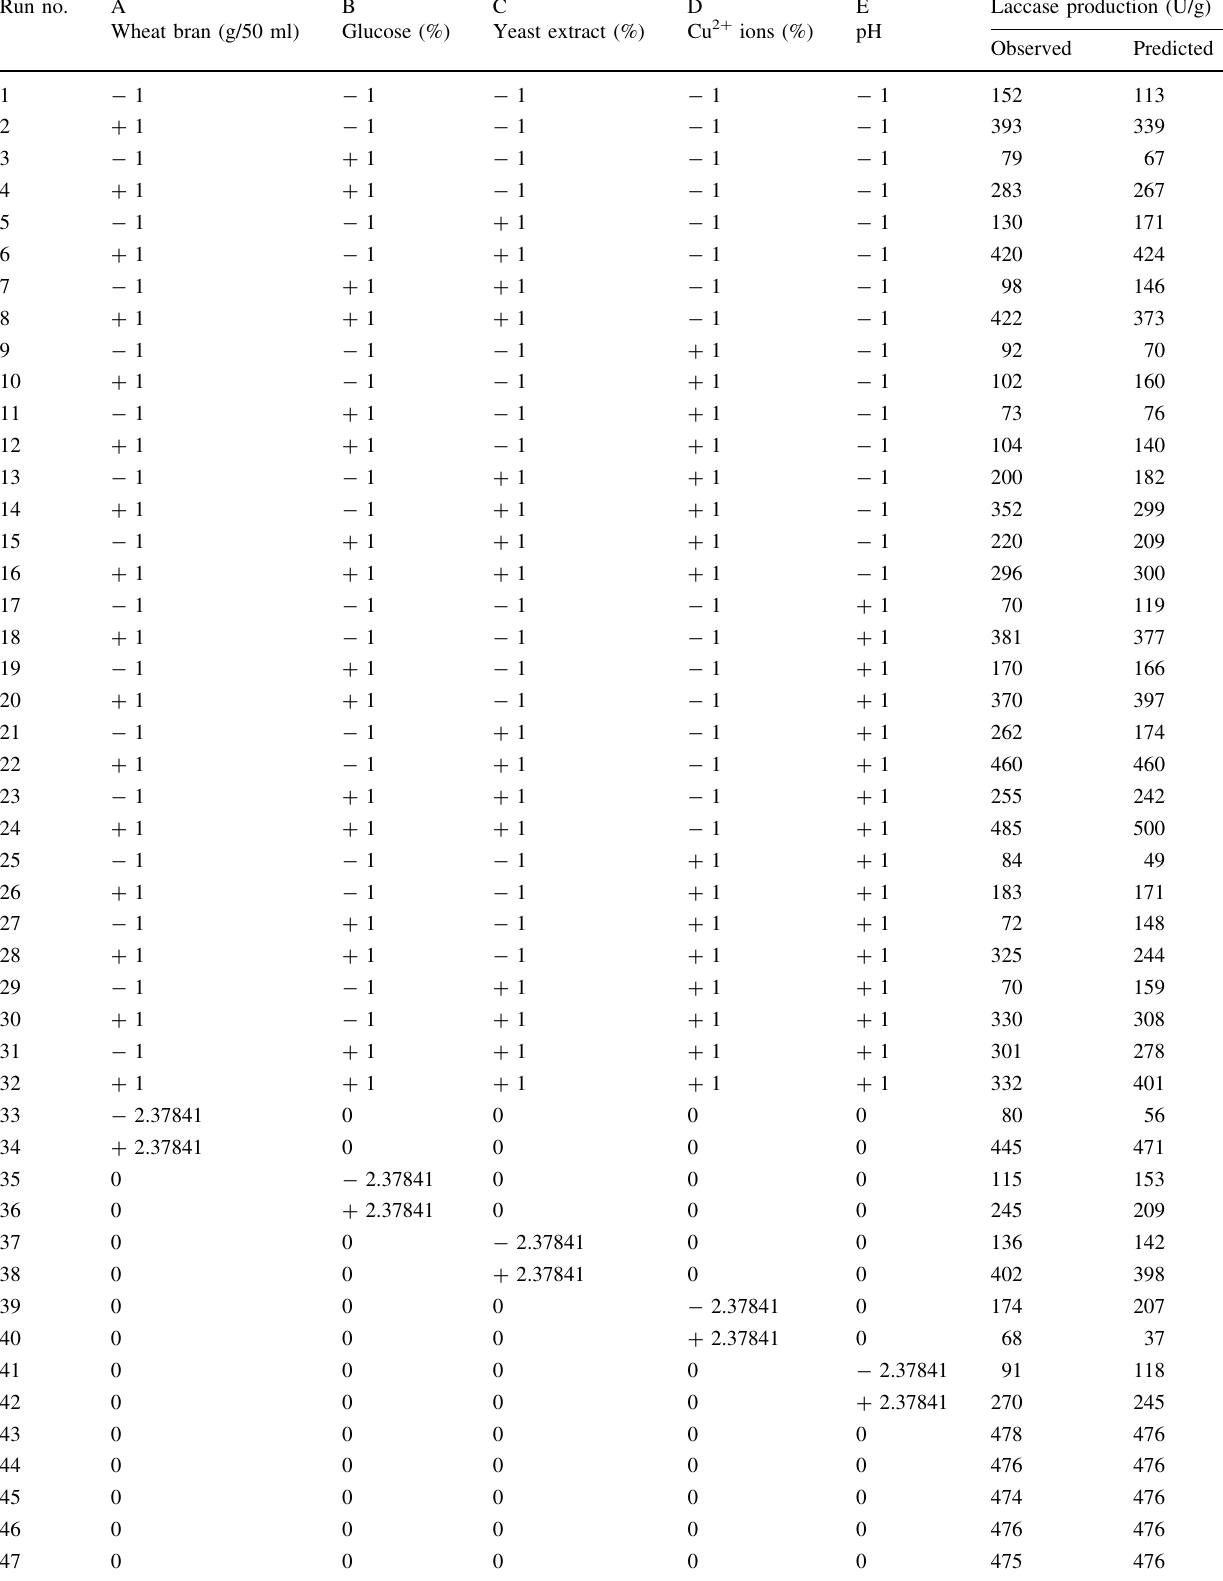
Table 3 Experimental design matrix for CCD-RSM of significant variables affecting laccase production Run